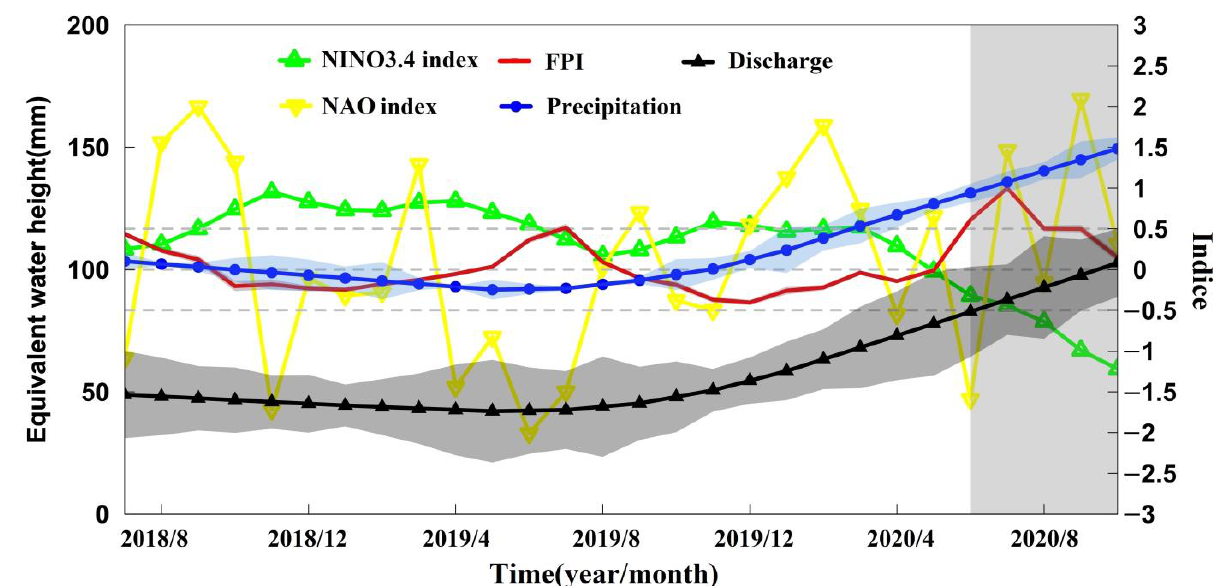
Figure 11. Non-seasonal GRAFO-derived discharge and precipitation, together with NINO3.4, NAO, and FPI indices in the Yangtze River basin between July 2018 and October 2020, on which the gray-blue shading means the period of 2020 basin-wide flood in the Yangtze River basin. The blue, black, and red shading donates the average standard deviation of precipitation, runoff, and FPI, respectively. The NINO3.4 series is taken as the 3-month moving average of the original NINO3.4 index.